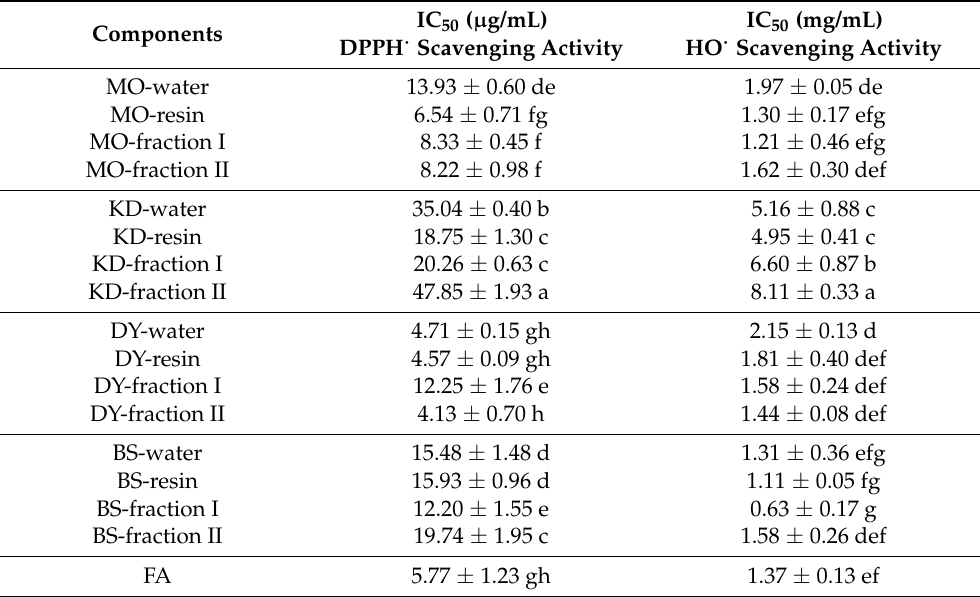
Table 3. The half Inhibitory concentration (IC 50 ) of DPPH · and HO · radical for herbal teas and green